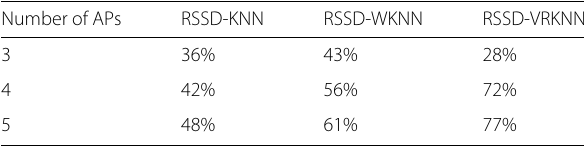
Table 3 The probability of location error ( ≤ 1.5 m) with different